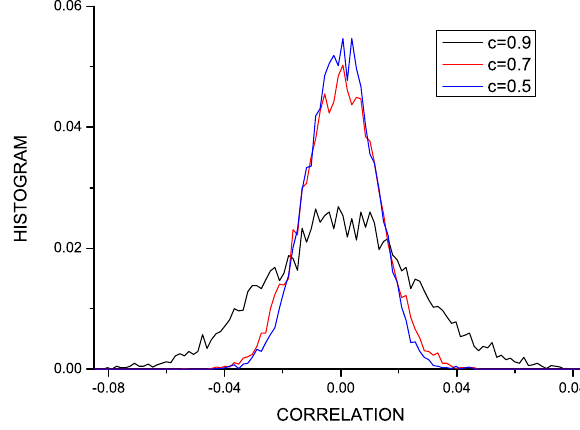
Fig. 1. Dependence of the entropy rate h G for the autoregressive process (7) on the parameter c .